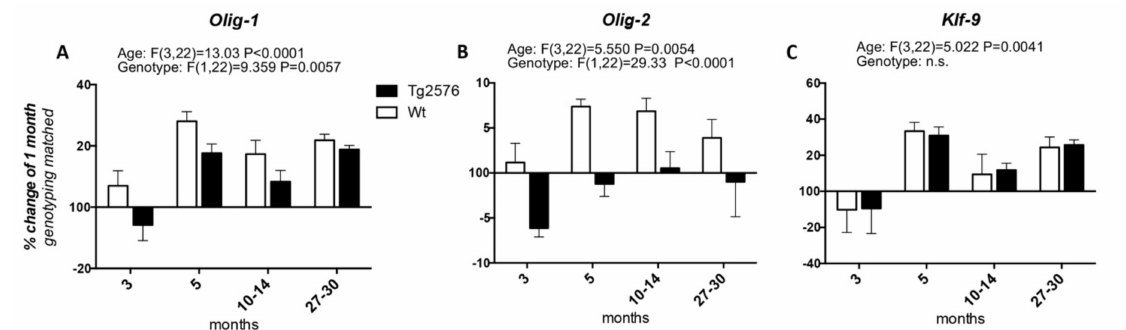
Figure 2. Age-related variation of oligodendrocyte precursor cells to oligodendrocyte transcription factors. The graphs show the expression profile of Olig-1 ( A ), Olig-2 ( B ), and Klf-9 ( C ) transcription factors. Relative expression has been normalized to 1-month for each genotype and given the value of 100%. Results are expressed as the % of variation compared to the 1-month genotype-matched, Wt and Tg2576, groups of animals. Statistical analysis has been performed through 2-wayANOVA, considering age (months) and genotype (Wt and Tg2576) as variables; n = 3–5. Results are significant when p <